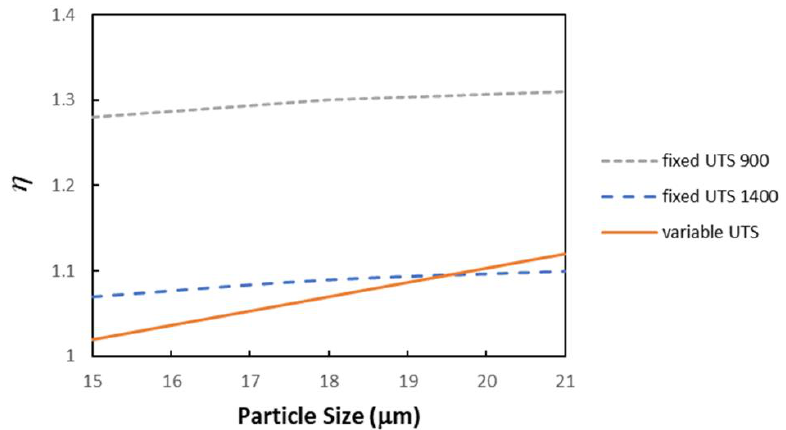
Figure 9. Calculated variation of the velocity ratio η = v p / v cr with particle size for the two cases where the (room-temperature) UTS is fixed and set to 900 and / or 1400 MPa, and where it is assumed to change with particle size (according the variation shown in Figure 8 for the case of adjustable particle size). The ratios are calculated by assuming a cold spray parameter set of p gas = 50 bar and T gas = 1000 °C.